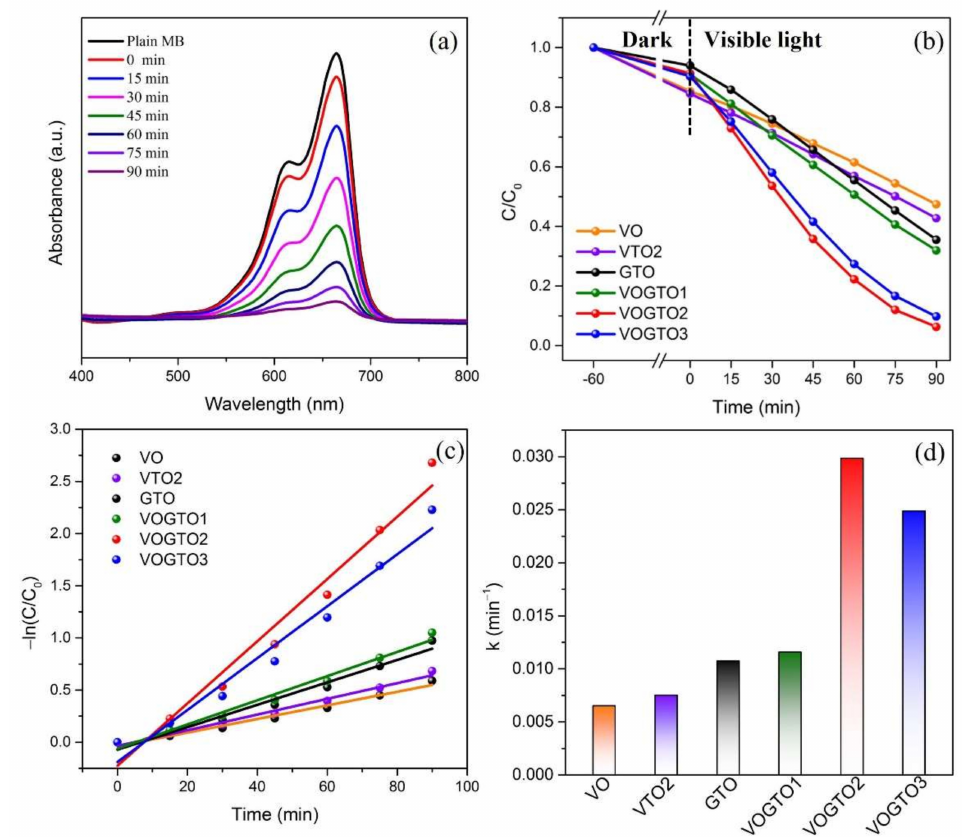
Figure 4. ( a ) Changes of UV − vis spectral absorption (MB) over VOGTO2 under visible-light irradi- ation; ( b ) Photocatalytic performance of prepared samples for MB degradation under visible-light irradiation; ( c ) Kinetic curves for degradation of MB and ( d ) apparent reaction rate constants over the photocatalysts. Table 1. Photocatalytic MB degradation of VOGTO2 compared with other reported similar photocatalysts.